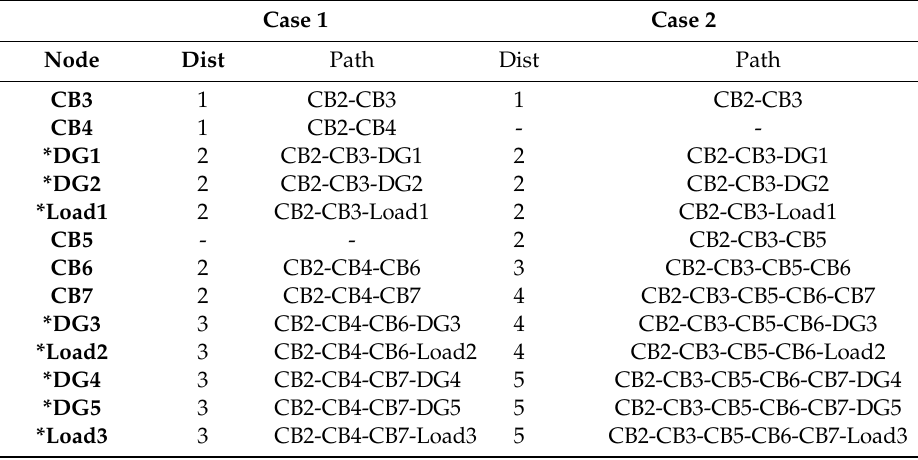
Figure 6. Dijkstra’s Algorithm run for case 1; path from CB2 to DG4. Table 1. Path from “Circuit Breaker